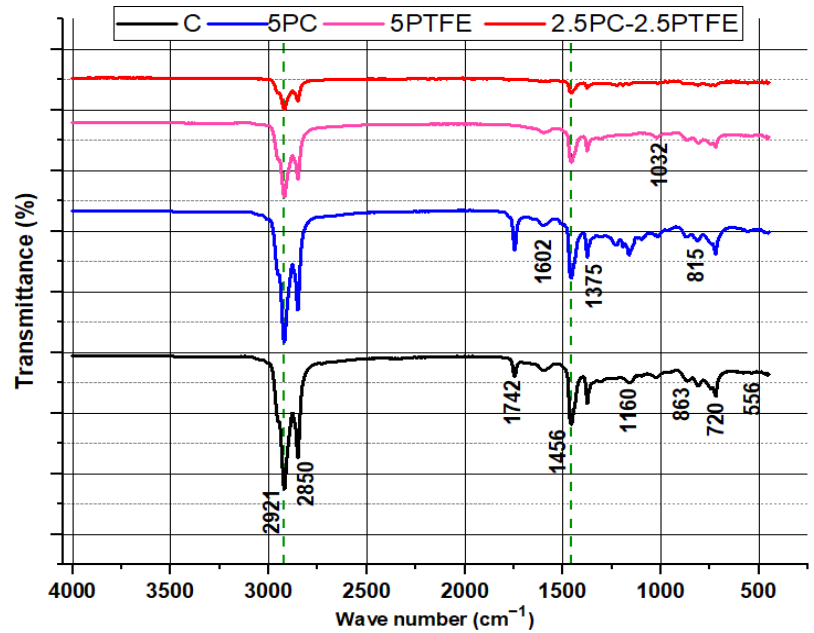
Figure 16. FTIR spectra of un-aged bitumen samples.